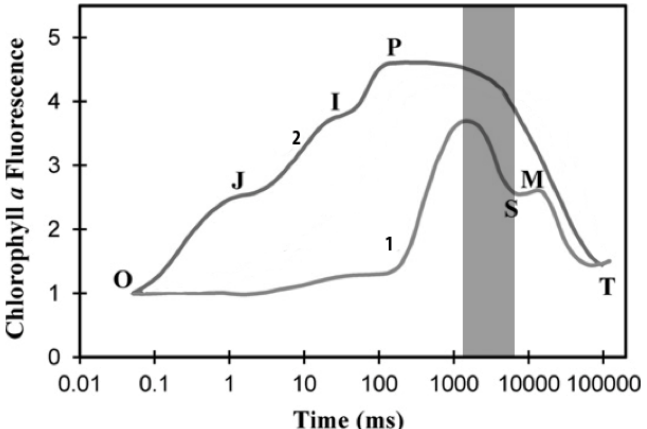
Figure 1. Chlorophyll a fluorescence induction transient, wavelength of excitation 650 nm from